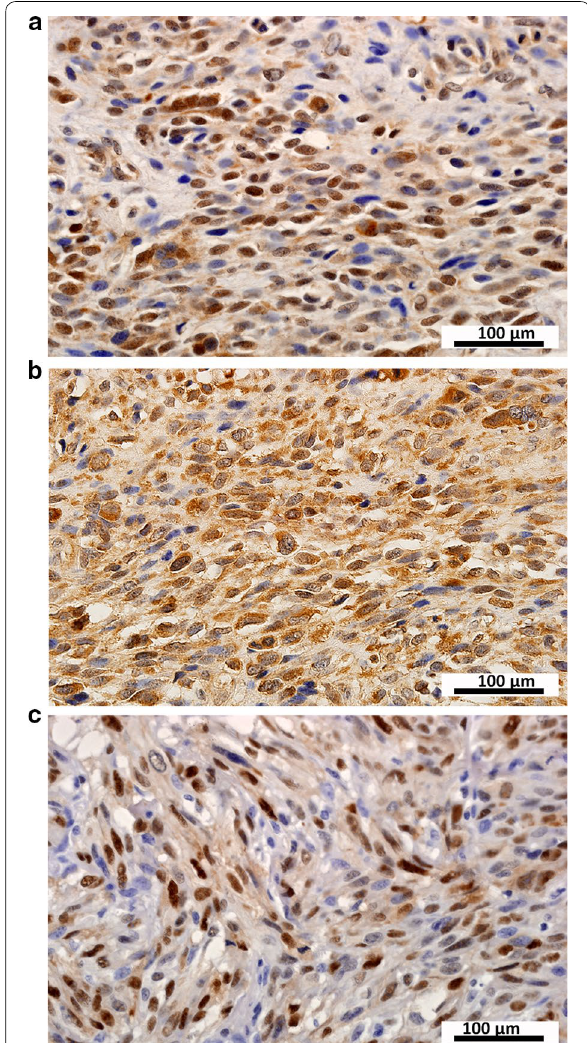
Fig. 1 Immunohistochemical analysis of C‑X‑C motif chemokine receptor 4 (CXCR4), C‑X‑C motif chemokine ligand 12 (CXCL12), and Cyclin D1 protein expression in sporadic malignant peripheral nerve sheath tumor tissue samples. a CXCR4 is mainly expressed in the cytoplasm and membrane. b CXCL12 is mainly presented in the cyto‑ plasm and plasma membrane. c Cyclin D1 is expressed in the